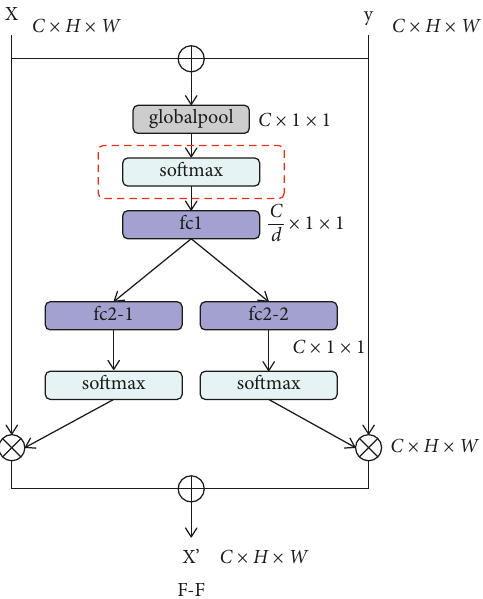
Figure 7: The improved SKNet feature fusion